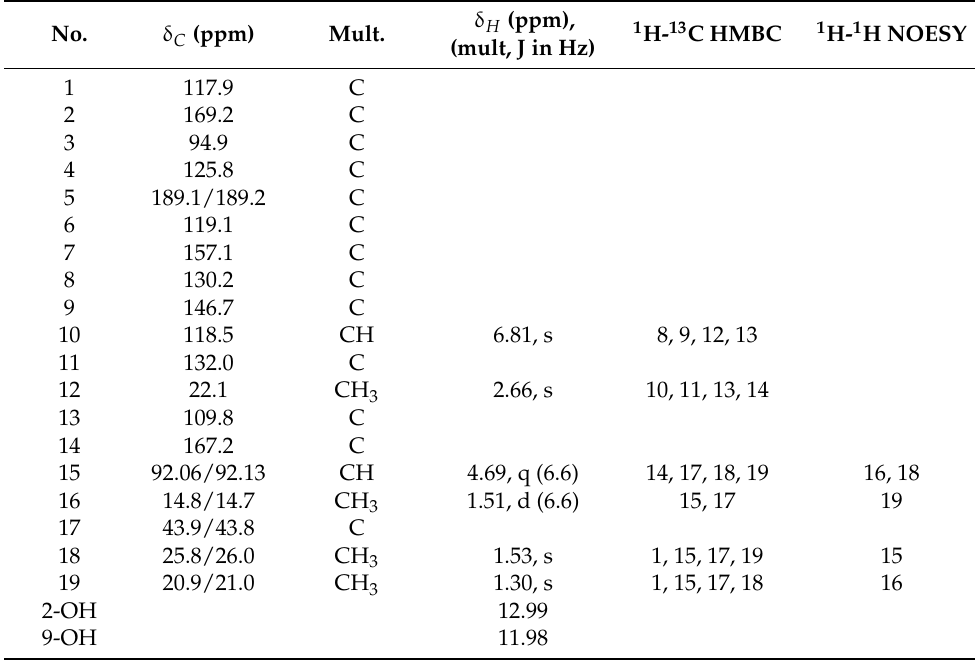
Table 5. NMR (CD 3 COCD 3 ) spectroscopic data for 6a